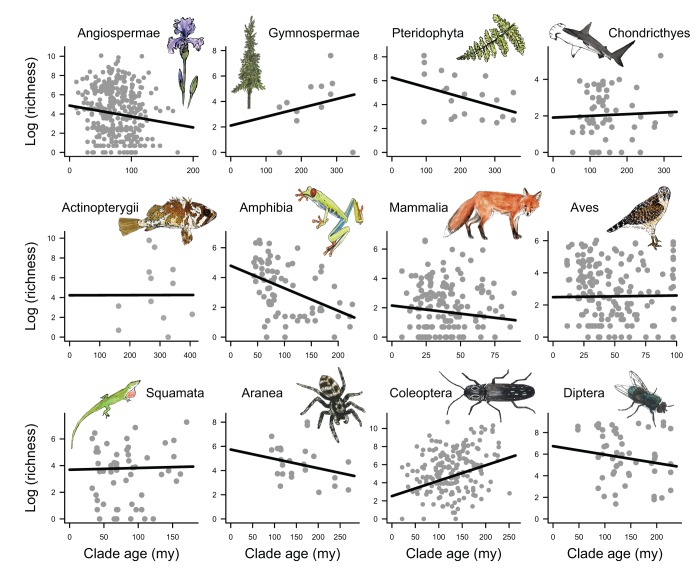
Relationships between age and richness within 12 major taxonomic groups
for which dense subclade sampling was available as part of the timetree
project [24].Lines represent fitted PGLS relationships between log(richness) and clade
age. Beetles show a significant age-diversity relationship
(β = 0.017,
p = 0.004). However, all slopes are
less than expected under both relaxed-rate and phylogenetic-rate models of
among-clade heterogeneity in net diversification rates (Table 1).